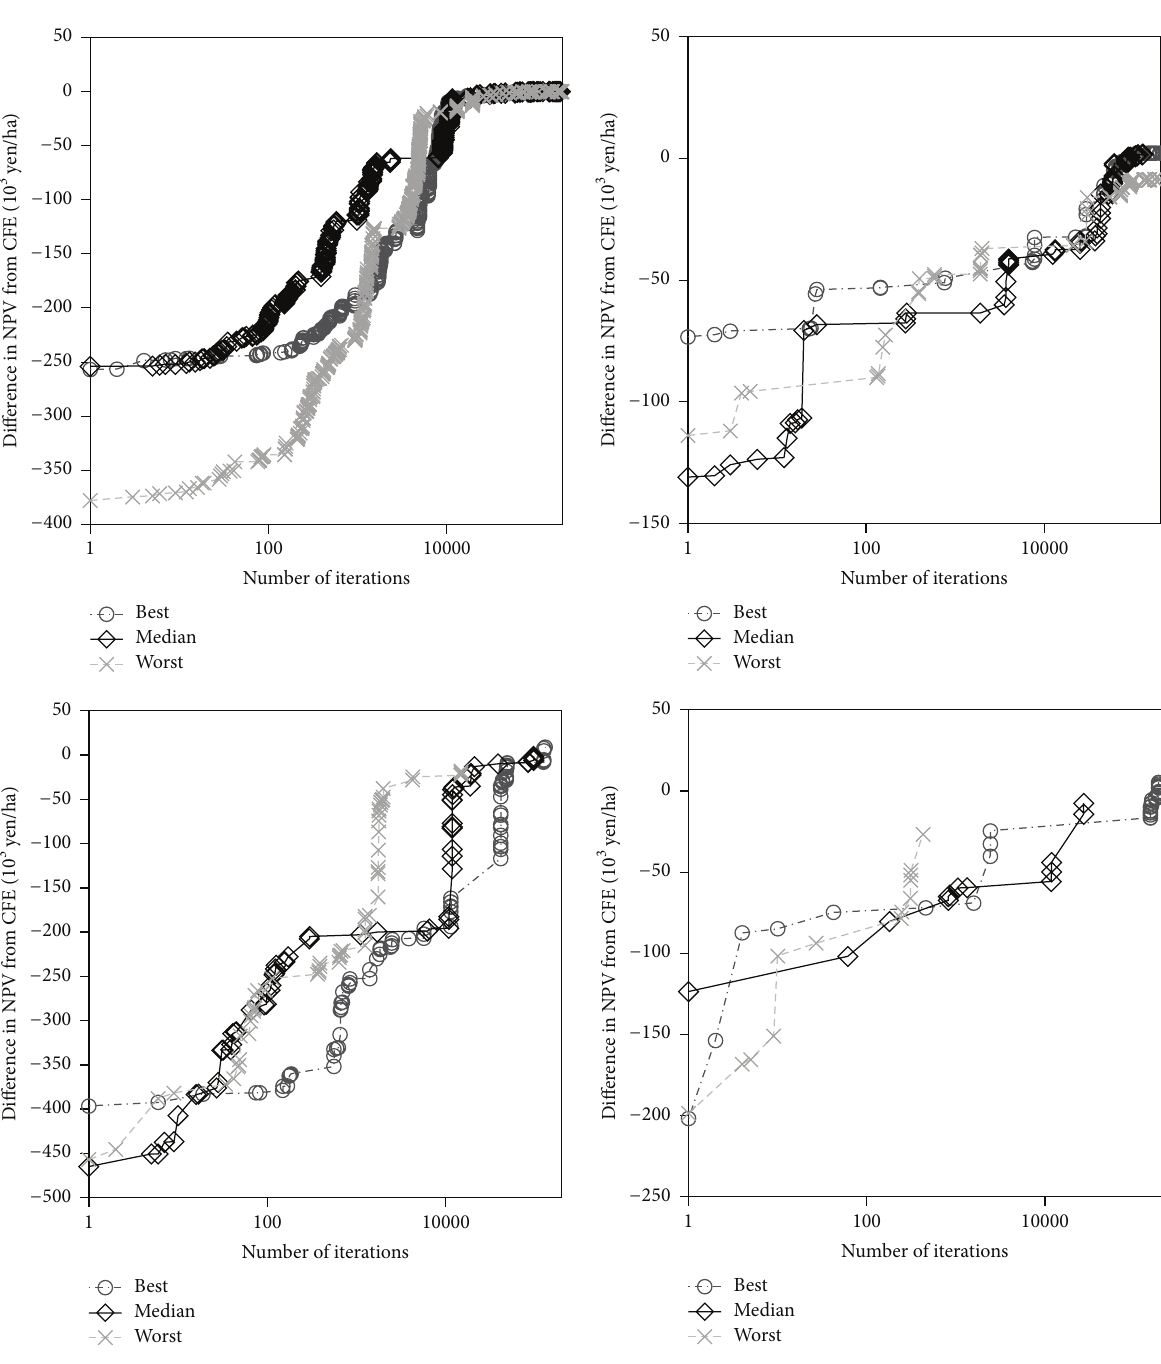
indicates that the change in final cutting cost resulted in large changes in the optimal solution. This suggests that the degree of variation in NPVs provided by SA was strongly influenced by the yield